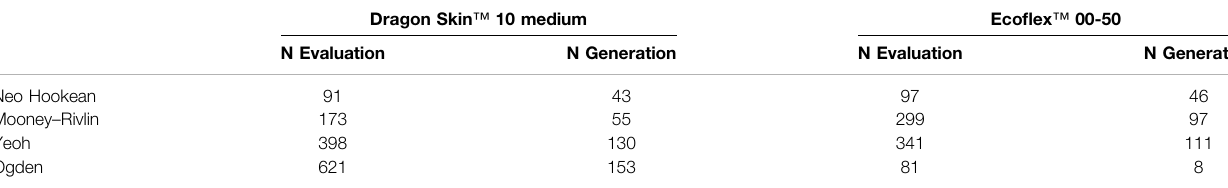
TABLE 4 | Number of function evaluations and generations required by the CMA-ES to characterize the